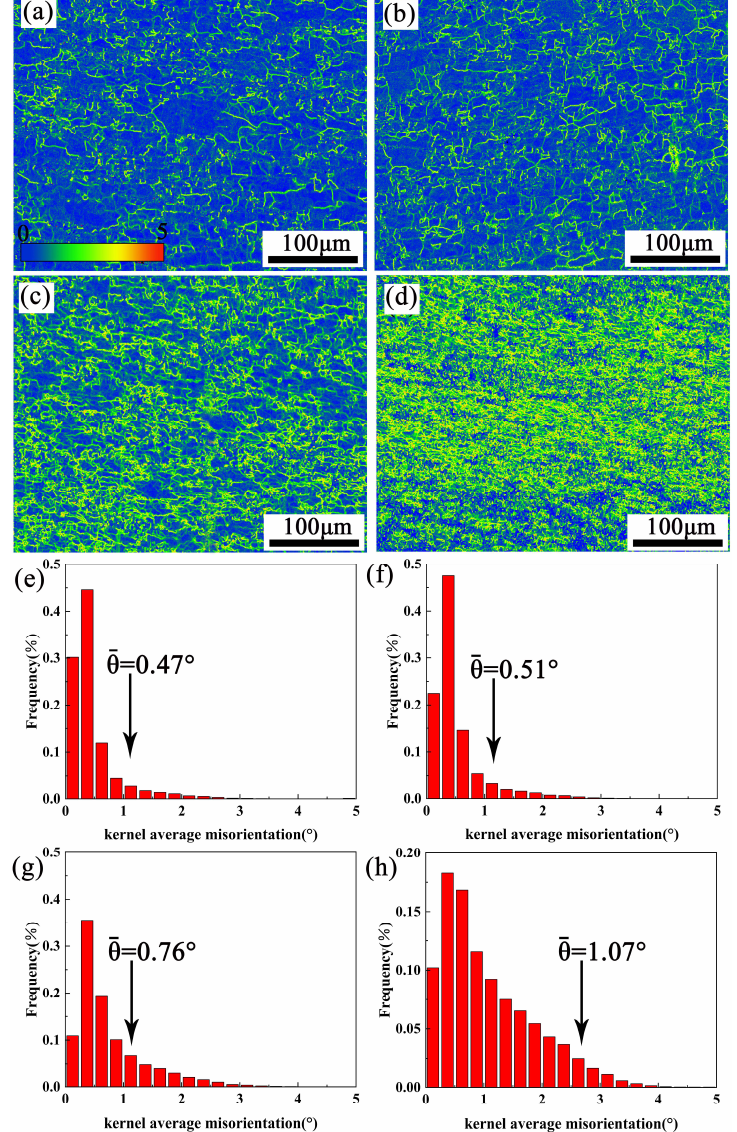
Figure 11. EBSD-kernel average misorientation (KAM) maps and local misorientation average angle of partial recrystallization for samples at 380 °C : ( a , e ) 0.001 s −1 , ( b , f ) 0.01 s −1 , ( c , g ) 0.1 s −1 ( d , h ) 1 s −1 .